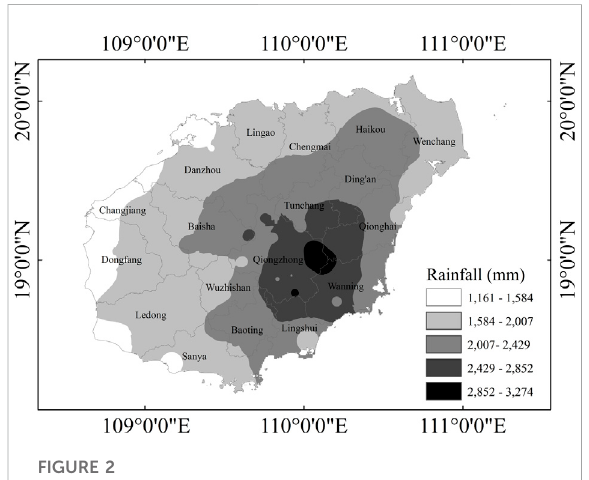
FIGURE 2 Spatial distribution of annual average rainfall in Hainan Island.